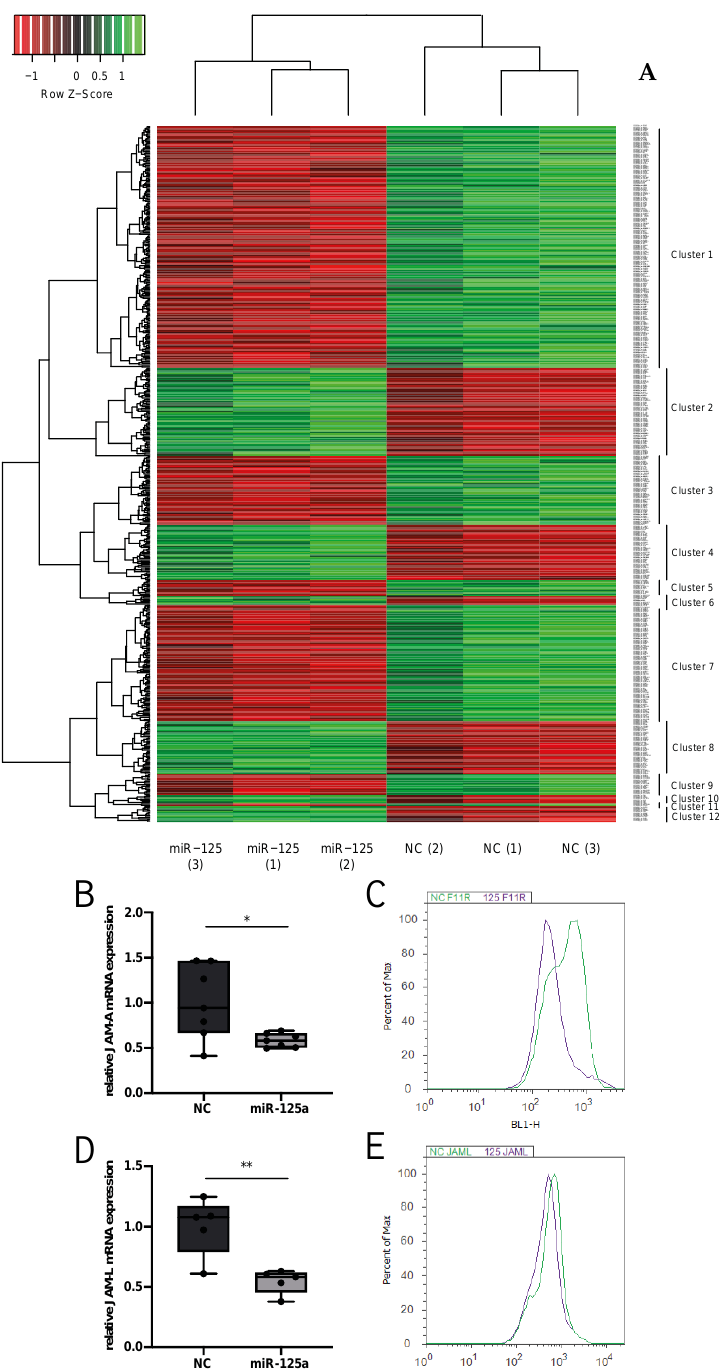
Figure 1. miR-125a regulates the expression of genes involved in monocyte adhesion. ( A ) Heatmap of differentially expressed genes in monocytes transfected with either miR-125a or scrambled control (NC) of three independent experiments and three individual donors, p < 0.05). Enhanced expression is indicated in green colour; reduced expression is indicated in red colour. The exact gene names, ordered by clusters, are provided in the Supplementary Information (Figure S2). mRNA expression of JAM-A ( B ) (n = 7, * p < 0.05) and JAM-L ( D ) (n = 5, ** p < 0.01) as measured by qRT-PCR ( C , E ). Surface protein expression of JAM-A and JAM-L in primary human monocytes after transfection of miR-125a (violet) or scrambled control (NC, green) as analysed by flow cytometry. A representative flow cytometric staining from a total of five independent experiments is